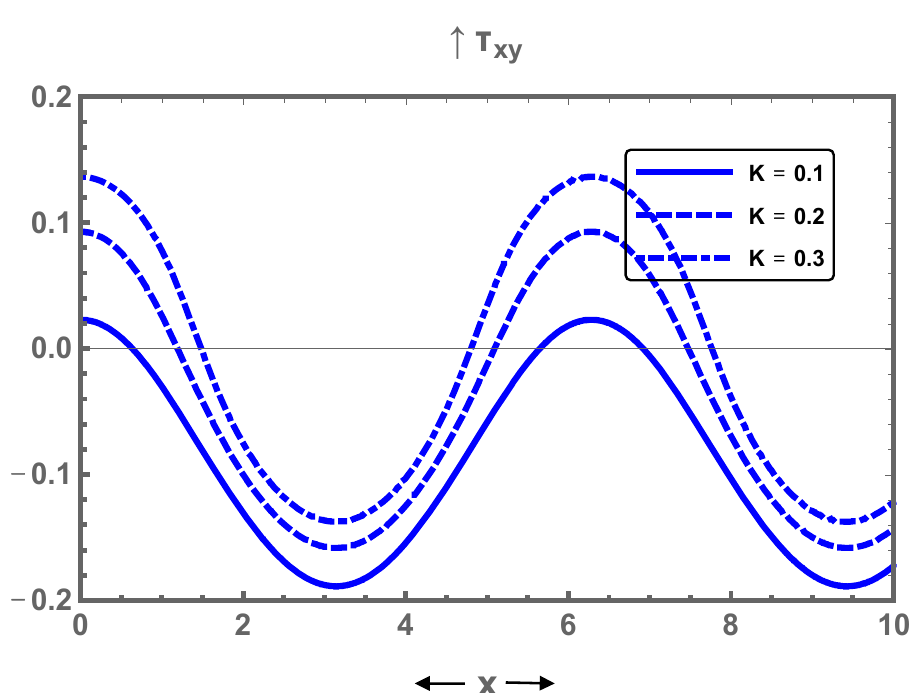
Figure 6. Display of shear stress profile for different values of K .